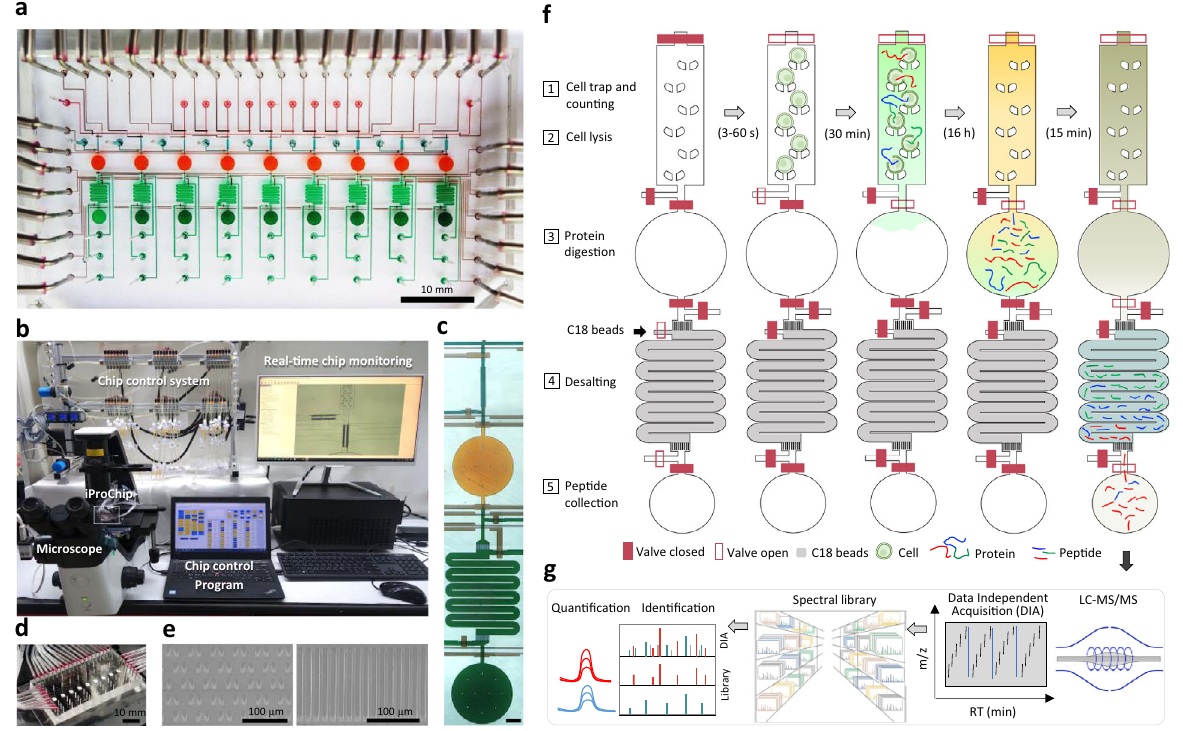
Fig. 1 Schematics of the integrated proteomics chip and streamlined work fl ow for nanoproteomics. a A bright- fi eld image of the integrated proteomics chip (iProChip), where cell capture chambers (cyan), reaction vessels (orange), on-chip SPE columns (green), sample collection ports (dark green), and control layers (brown) are shown. b The entire system set-up for iProChip operation. c A close-up view of a single operation unit. Scale bar: 300 μ m. d